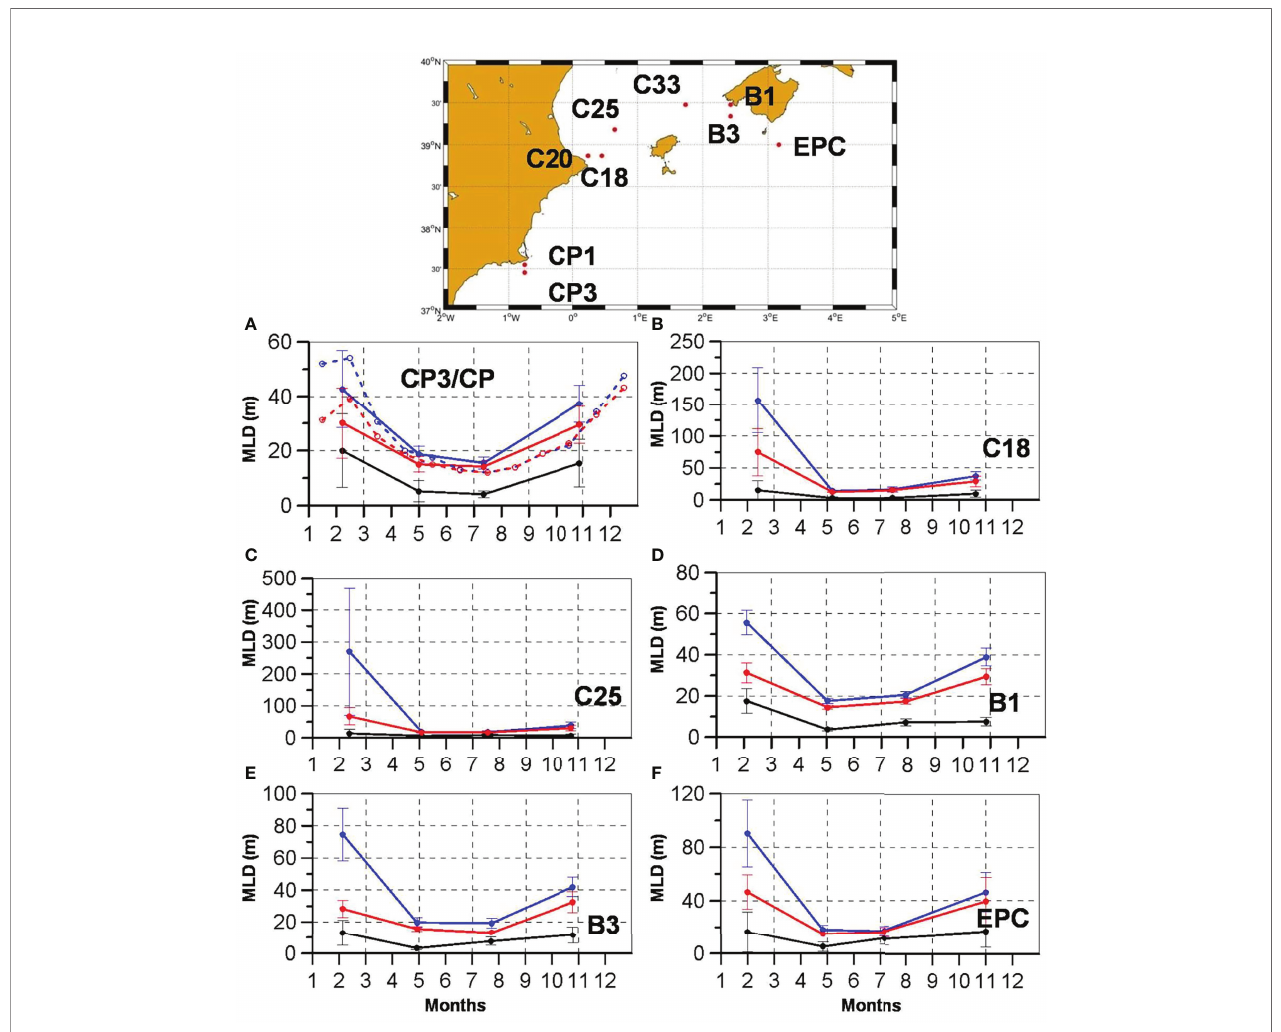
FIGURE 5 | Seasonal cycles of the MLD estimated from the three-monthly sampling of RADMED projects (continuous lines) at some selected oceanographic stations (see labels inserted in these fi gures and the map for the locations), and form the Argo MLD at the region of Cape Palos (A) (dashed lines). Blue lines correspond to the t-threshold method, red lines to the d-threshold method, and black lines to the temperature extreme curvature method. Please, note the different ranges of the y-axis between